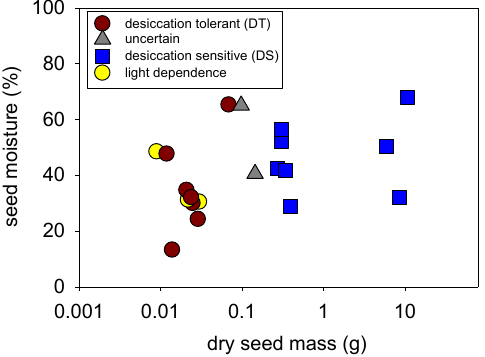
Figure 1. Seed moisture at dispersal of 20 liana species of the Central Amazon in relation to seed size (dry mass) with indication of desiccation tolerance or desiccation sensitivity of the seeds and necessity of light for germination (photoblastic seeds). Note log-scale at